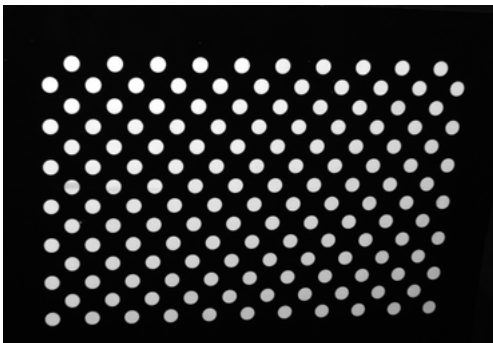
Figure 8. 7 × 21 circle board used for